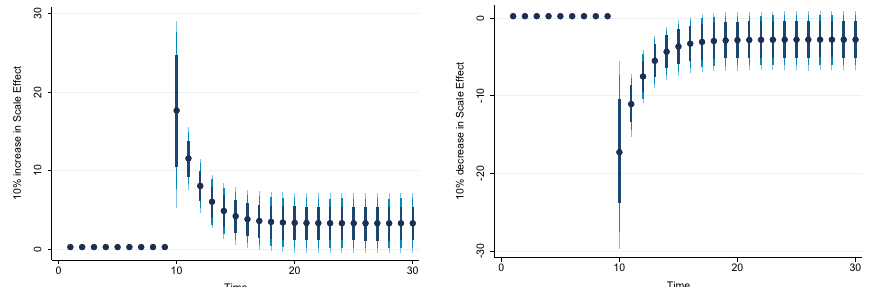
Fig. 1 The impulse response plot for scale effect (economic growth) and CO 2 emissions. This figure shows a 10% increase and a decrease in scale effect and its influence on CO 2 emissions where dots specify average prediction value. However, the dark blue to light blue line denotes 75, 90, and 95% confidence interval,